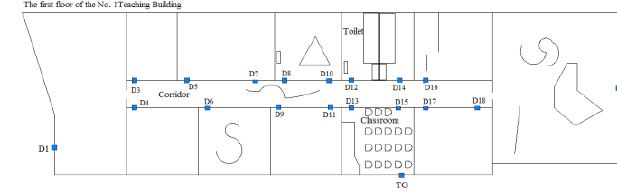
Figure 14. Simplified plan